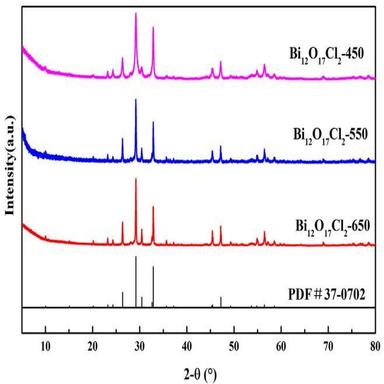
UV–Vis diffuse reflectance spectra of different Bi12O17Cl2 samples (A), and band-gap energy values determined via the plotted curve of (αhυ) 2 versus hυ and photoluminescence spectra (inset) (B).